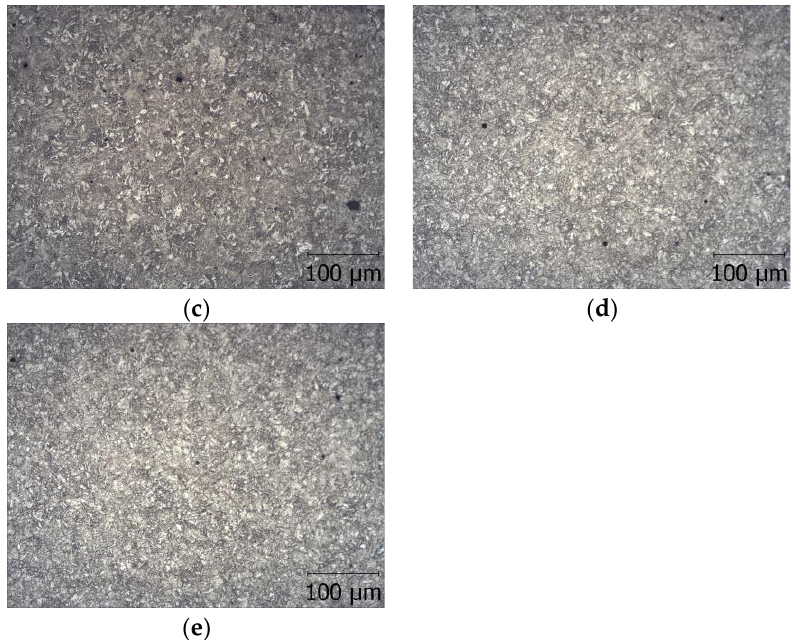
Figure 1. Microstructure of the tested steel after being hardened at 880 °C and tempered at ( a ) 200 °C, ( b ) 300 °C, ( c ) 400 °C, ( d ) 500 °C, and ( e ) 600 °C.